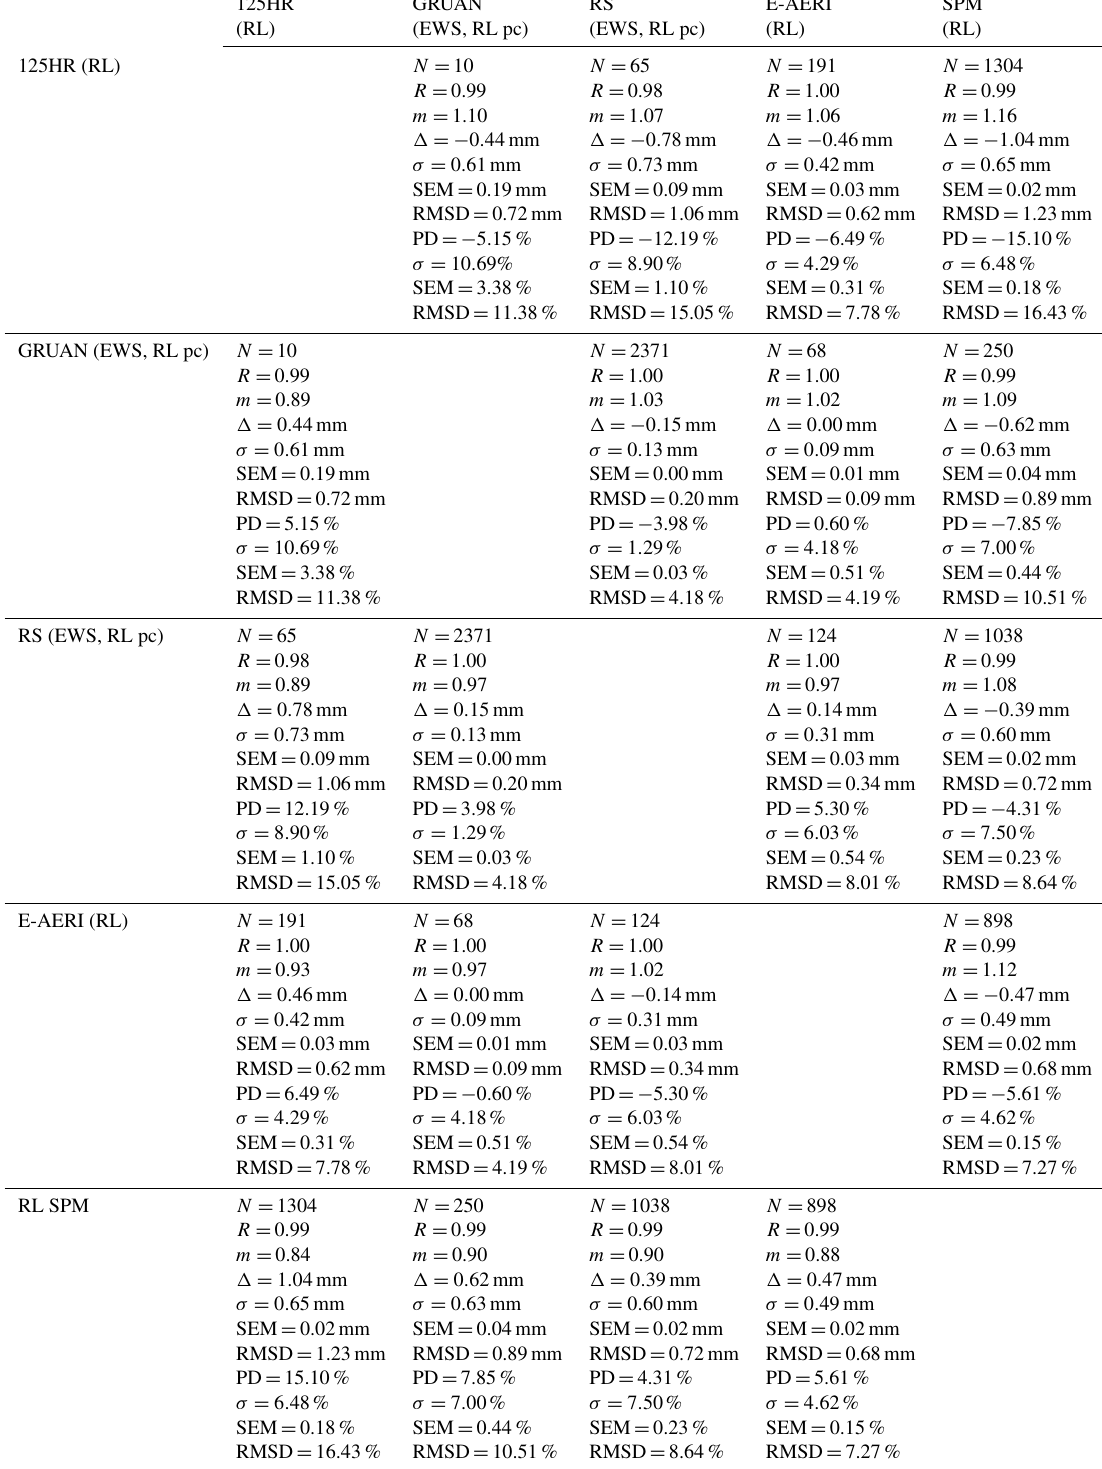
Table 4. Results of intercomparison of PWV measurements at the Ridge Lab, including number of coincidences ( N ), correlation coefficient ( R ), slope of the correlation best fit line ( m ), mean difference ( (cid:49)) , standard deviation of difference ( σ) , standard error of the mean (SEM), and root-mean-square difference (RMSD) in mm and %. Instruments along the x axis (top) are X while instruments along the y axis (side) are Y in Eqs. (1) and (2). A high-resolution version of this table can be found in the Supplement as Table